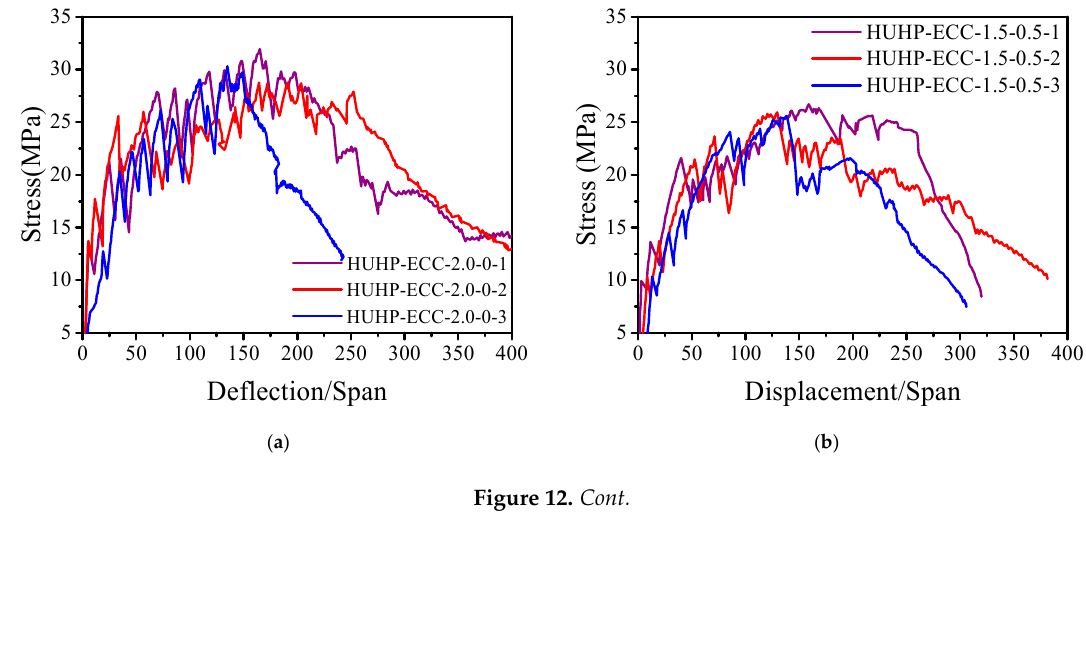
( f ) Figure 12. Stress versus displacement curves of HUHP-ECCs. ( a ) HUHP-ECC-2.0-0; ( b ) HUHP-ECC-1.5-0.5; ( c ) HUHP-ECC-1.0-1.0; ( d ) HUHP-ECC-0.5-1.5; ( e ) HUHP-ECC-0-2.0; ( f ) Typical stress versus displacement curves.